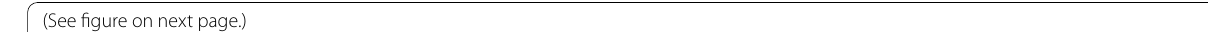
66/20)(See figure on next Fig. 7 Characteristic facies of the carbonate rocks: A Branched coralline algal facies with few dolomitic lithoclasts (HA 518/12). B Branched and crustose coralline algal facies (HA 511/1). C Boxwork rhodolites facies (HA 518/9). D Bryozoan-coralline algal facies; branched bryozoan colonies are incrusted by coralline algae (HA 511/3). E Maërl facies with small but very abundant algal branch fragments (HA 511/1). F Amphistegina facies with densely packed, bioturbated Amphistegina mudstone and molluscs in the upper part (HA